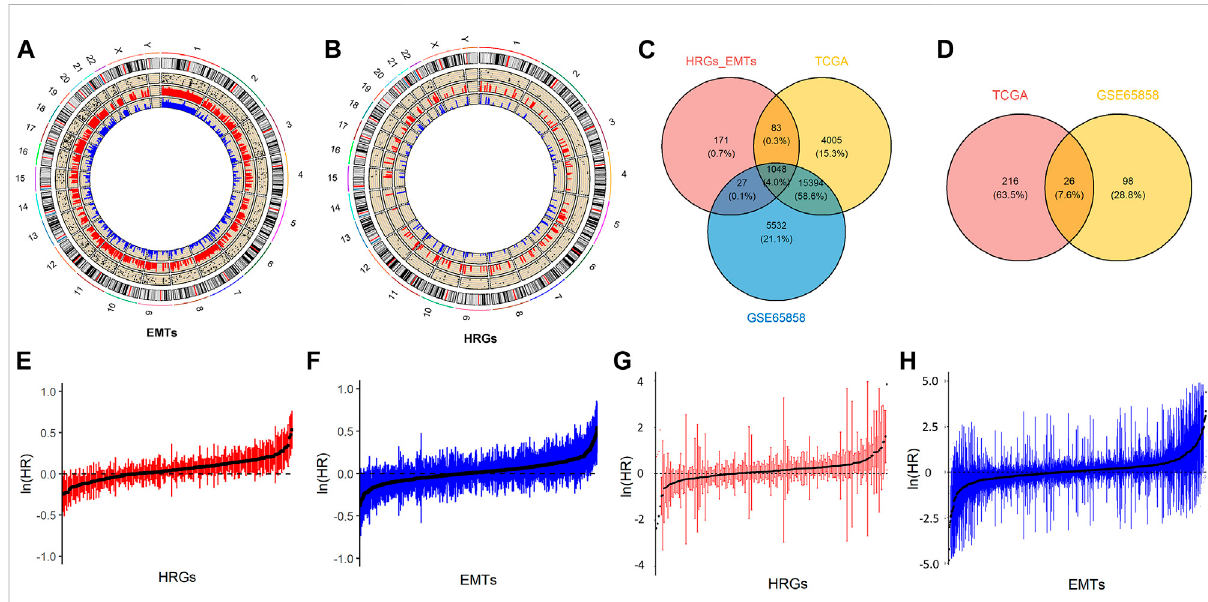
FIGURE 1 Prognostic associated HRGs and EMTs. (A) . Circos plot of EMTs, including the locations of candidate genes in the genome, and the relative expressionlevelsintheTCGAandtheGSE65858. (B) .CircosplotofHRGs,includingthelocationsofcandidategenesinthegenome,andtherelative expression levels in the TCGA and the GSE65858. (C) . Mapping results of HRGs and EMTs in TCGA and GSE65858 datasets. (D) . Prognostic factors wereselectedfrom TCGA and GSE65858 datasets. (E,F) . Visualizationof HRGs and EMTs in TCGA dataset byunivariateCox regressionanalysis. (G,H) . Visualization of HRGs and EMTs in GSE65858 dataset by univariate Cox